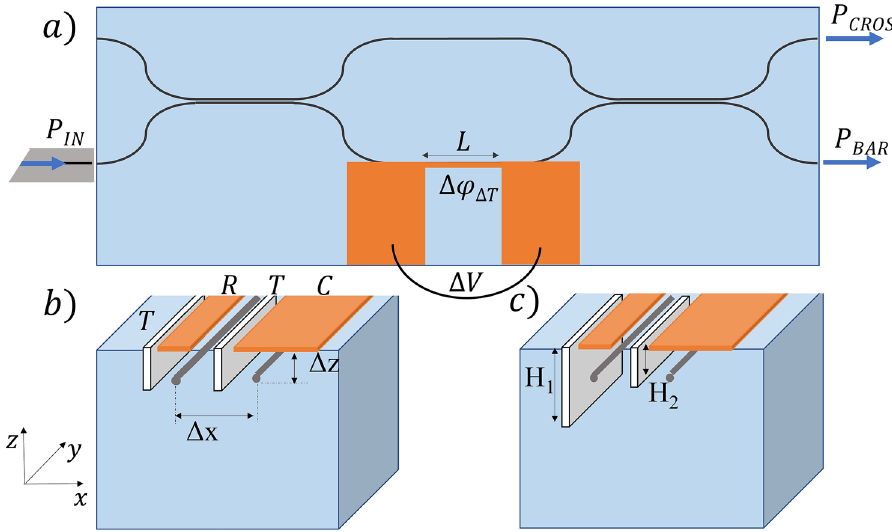
Figure 1. ( a ) Schematic of the MZI device in the standard configuration . ( b ) and ( c ) Two advanced configurations introduced to speed up the dynamic response of the optical modulator. R, C and T stands for resistor, conductive layer, and trench, respectively. Δz and Δx correspond to the depth of the waveguides from the surface and the reciprocal distance. H1 and H2 indicate the height of the trenches, which is the same for the two trenches in panel b ( symmetric configuration ) and different in panel c ( asymmetric configuration